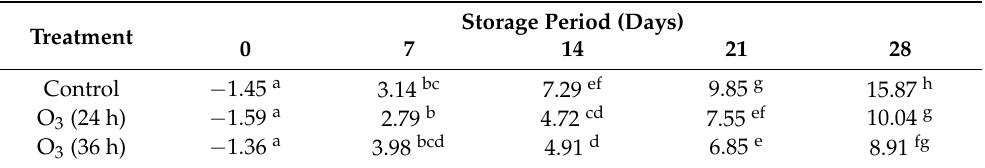
Table 4. Effect of gaseous ozone (0.25 mg/L) on a* values of mango fruit inoculated with L. theobromae , stored at 10 ◦ C for three weeks, and ripened at ambient temperature for one week.